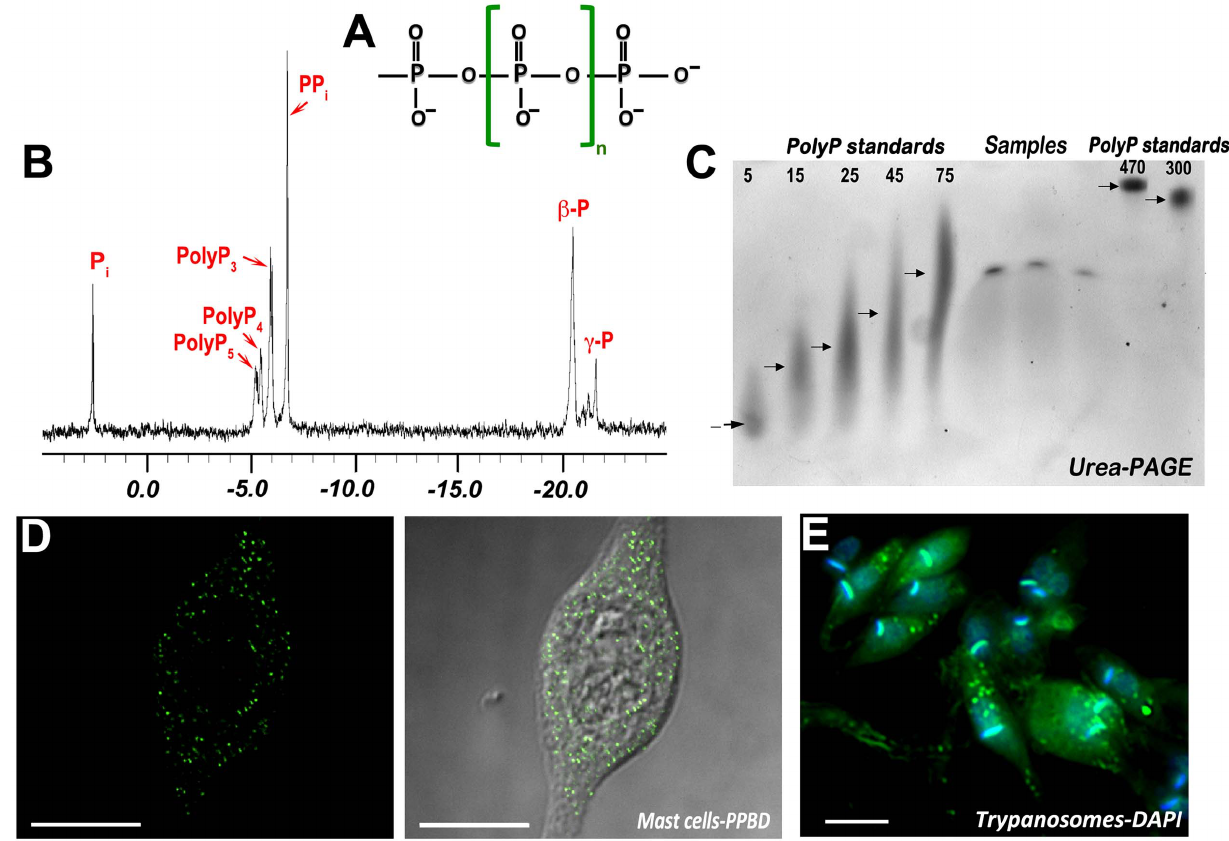
Figure 1. Methods used to detect polyP in cells. (A) Structure of polyP. (B) 303.6-MHz spectrum ( 1 H decoupled) of a perchloric acid extract of isolated acidocalcisomes from epimastigotes of T. cruzi , showing peaks corresponding to P i ; the a phosphates of pentapolyphosphate (polyP 5 ), tetrapolyphosphate (polyP 4 ), tripolyphosphate (polyP 3 ); PP i ; the b phosphates of tri-, tetra-, and pentapolyphosphate ( b -P); and the c phosphate (central) of pentapolyphosphate ( c -P). Reproduced with permission from reference [31], (cid:2) the American Society for Biochemistry and Molecular Biology. (C) Urea-PAGE analysis of polyP from human platelets from three different donors. PolyP extracted from platelets was electrophoresed by 6% urea-PAGE. Chain lengths of standards are on the left . The lanes named ‘‘Samples’’ show the position of migration of samples from three different donors. Reproduced with permission from reference [22], (cid:2) the American Society for Biochemistry and Molecular Biology. (D) Fluorescence analysis ( left ) and merge with bright field image ( right ) of the localization of polyP in mast cell granules (acidocalcisomes) using the recombinant polyP binding domain (PPBD) of Escherichia coli PPX linked with an Xpress epitope tag. Reproduced with permission from reference [23], (cid:2) the American Society for Biochemistry and Molecular Biology. (E) DAPI staining of epimastigotes of T. cruzi showing the punctate staining of acidocalcisomes. Kinetoplast DNA is stained blue.